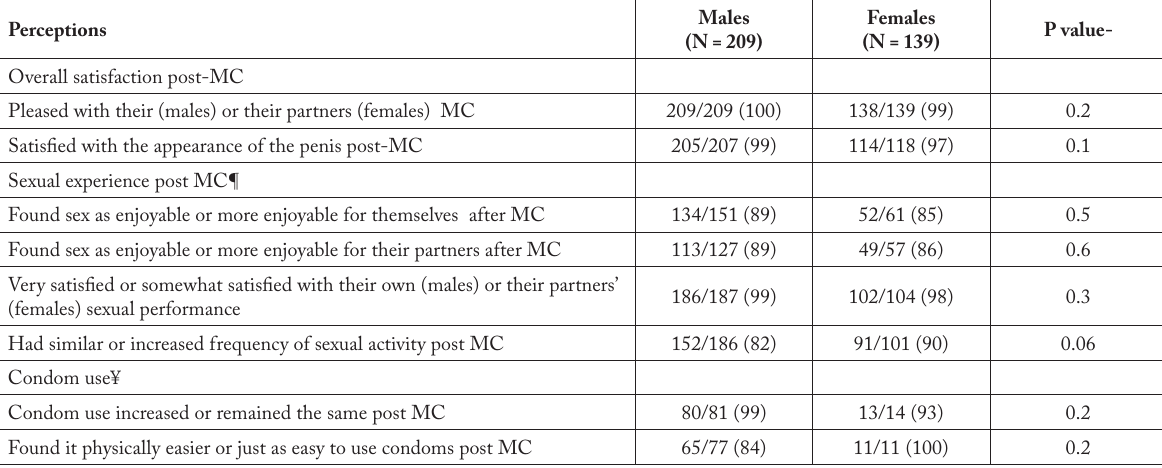
Table 6. Sexual satisfaction and pleasure among sexually active recently circumcised men and women with